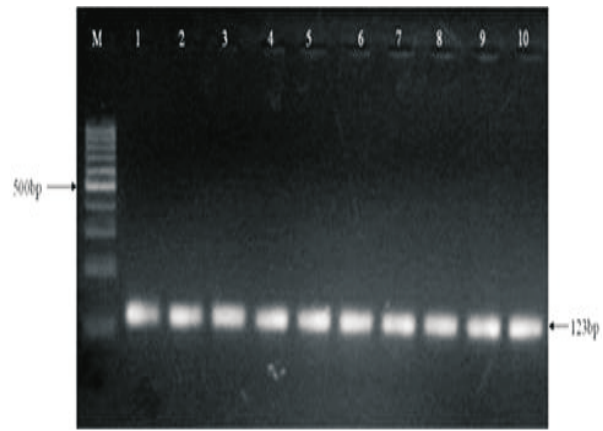
Figure-2. Limit of detection of RNA of isolate KMNO7 (BTV-21) using ns1 gene specific RT-PCR. Lanes: M- 100 bp ladder; 1- 70.0pg; 2